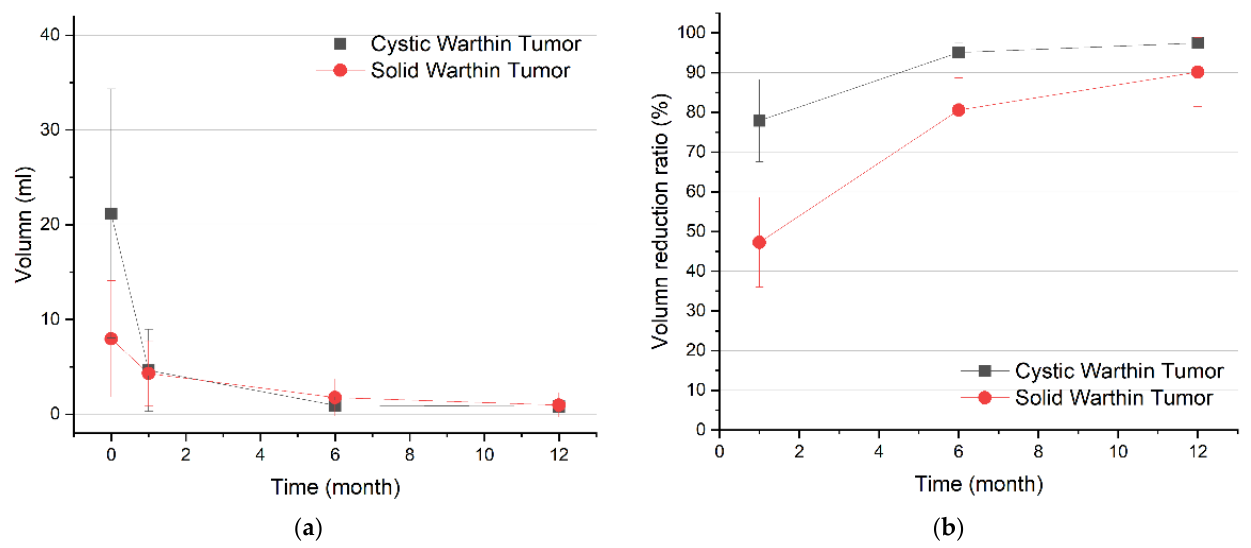
Figure 2. Comparison of outcomes for cystic versus solid Warthin tumors. ( a) Changes in tumor volume at each follow-up. ( b ) Changes in VRR at each follow-up. VRR = volume reduction ratio. Table 2. Comparison of Warthin Tumor by Groups.